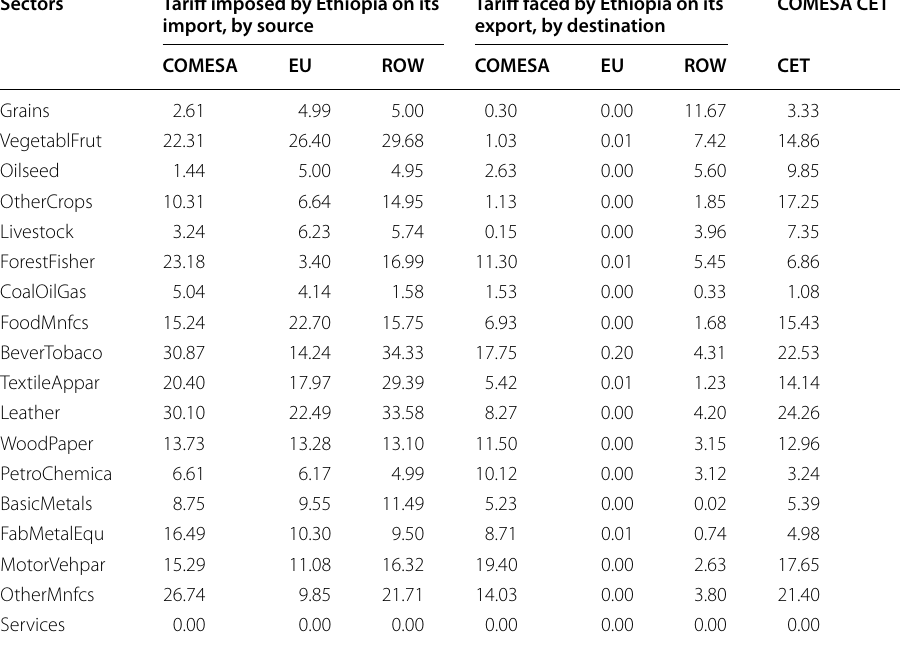
Table 3 Tariff protection structure for Ethiopia, by aggregated GTAP sector (Percentage). Source: GTAP 9 database, and COMSTAT Data